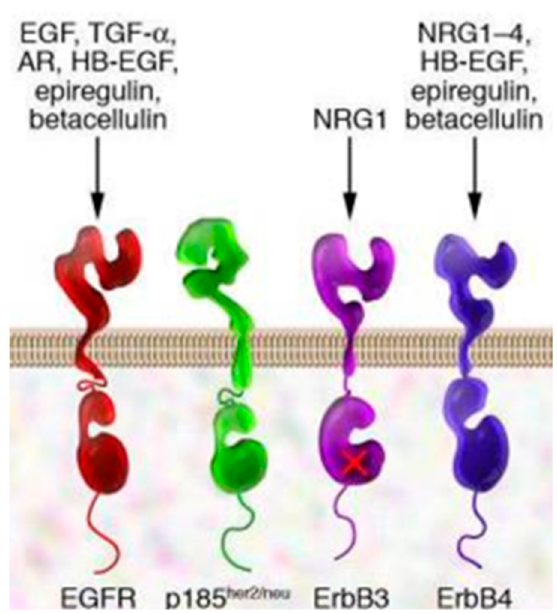
Figure 1. Epidermal growth factor receptors(EGFR), p185 (neu oncogene originally identified in cell lines derived from rat neuroectodermal tumors. neu is related to but distinct from the c-erbB gene, which encodes the epidermal growth factor (EGF) receptor. It encodes a protein, designated p185, that is serologically related to the EGF receptors), ErbB3 (receptor tyrosine-protein kinase, is a membrane bound protein that in humans is encoded by the ERBB3), ErbB4 (receptor tyrosine-protein kinase, is an enzyme that in humans is encoded by the ERBB4 gene). EGFR specific ligands: transforming growth factor alfa (TGF- α ), androgen receptor (AR), Neuregulin 1 (NRG1, NRG1-4), heparin-binding EGF-like growth factor (HB-EGF).